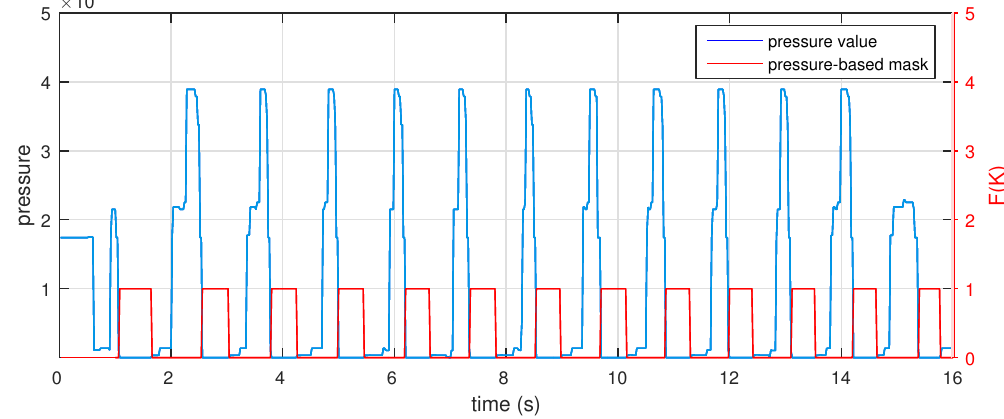
Figure 5. Swing phase determination based on pressure information.